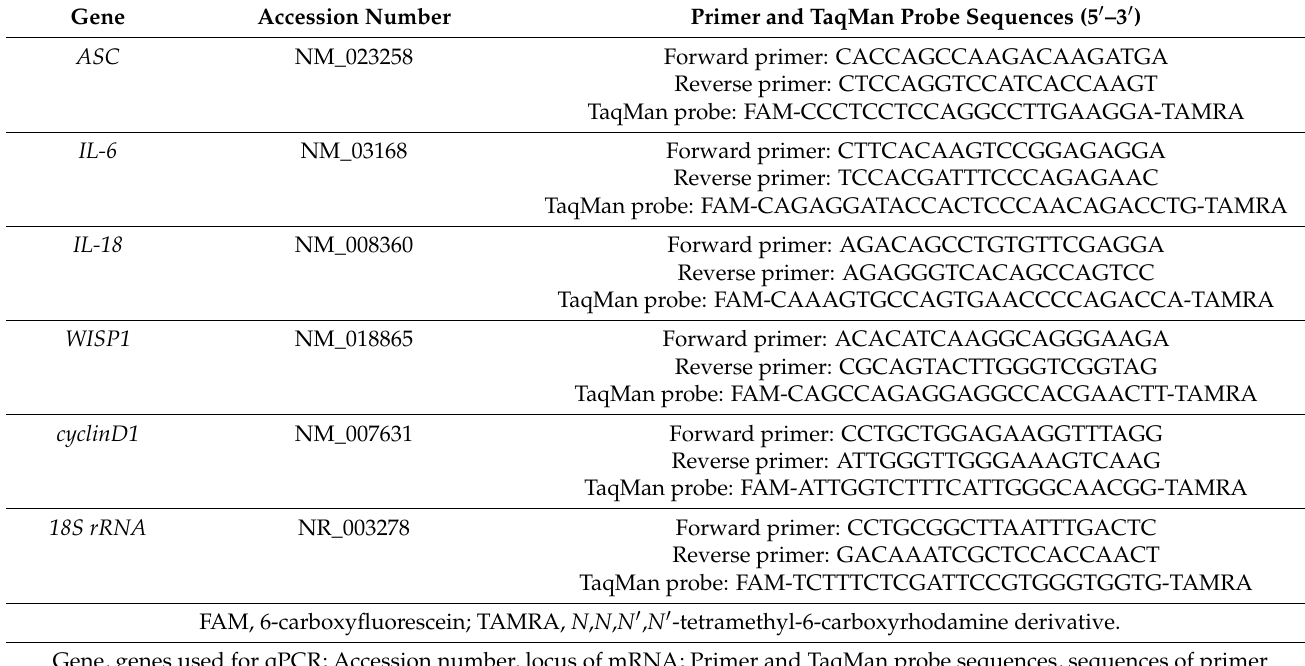
Table 1. Primer and probe sequences used for real-time polymerase chain